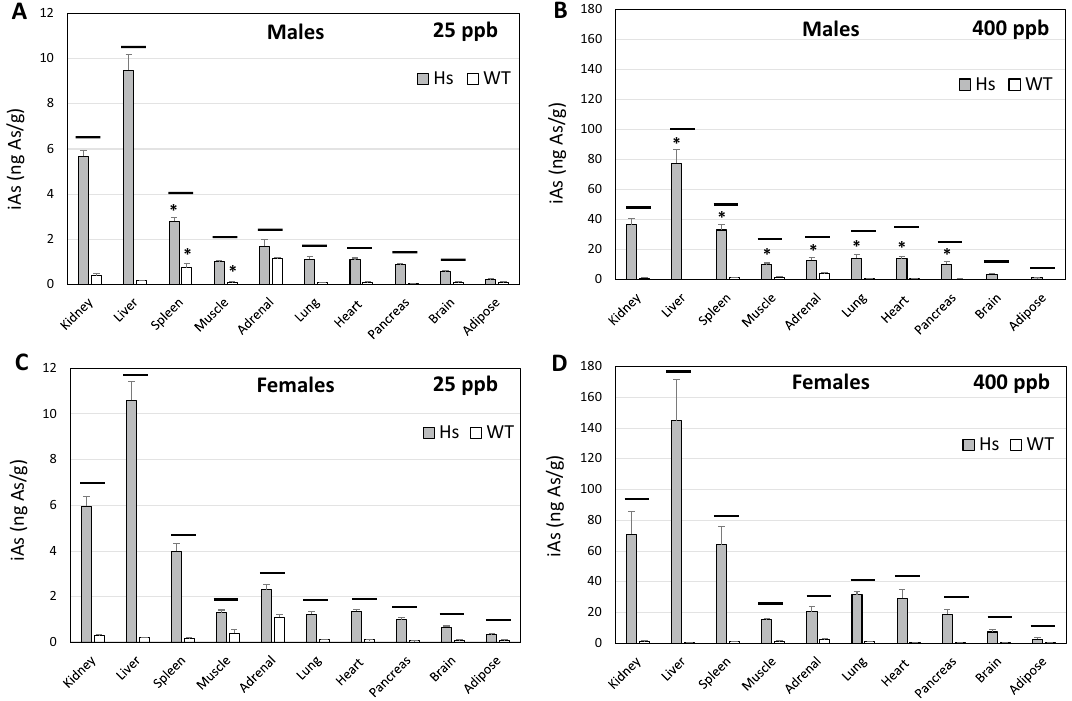
Figure 3. Concentrations of iAs in tissues of humanized (Hs) and wild-type (WT) male and female mice after 4-week exposure to 25-ppb ( A , C ) or 400-ppb ( B , D ) of inorganic arsenic in drinking water. Each bar and whisker represent mean and SEM value, respectively. For 25-ppb exposure, N = 6 for Hs males and WT males, and N = 8 for Hs females and WT females. For 400-ppb exposure, N = 7 and 8 for Hs males and WT males, respectively, and N = 10 and 11 for Hs females and WT females, respectively. Horizontal line marks significant difference between genotypes for individual tissue; asterisk marks significant difference between males and females of the same genotype (p <